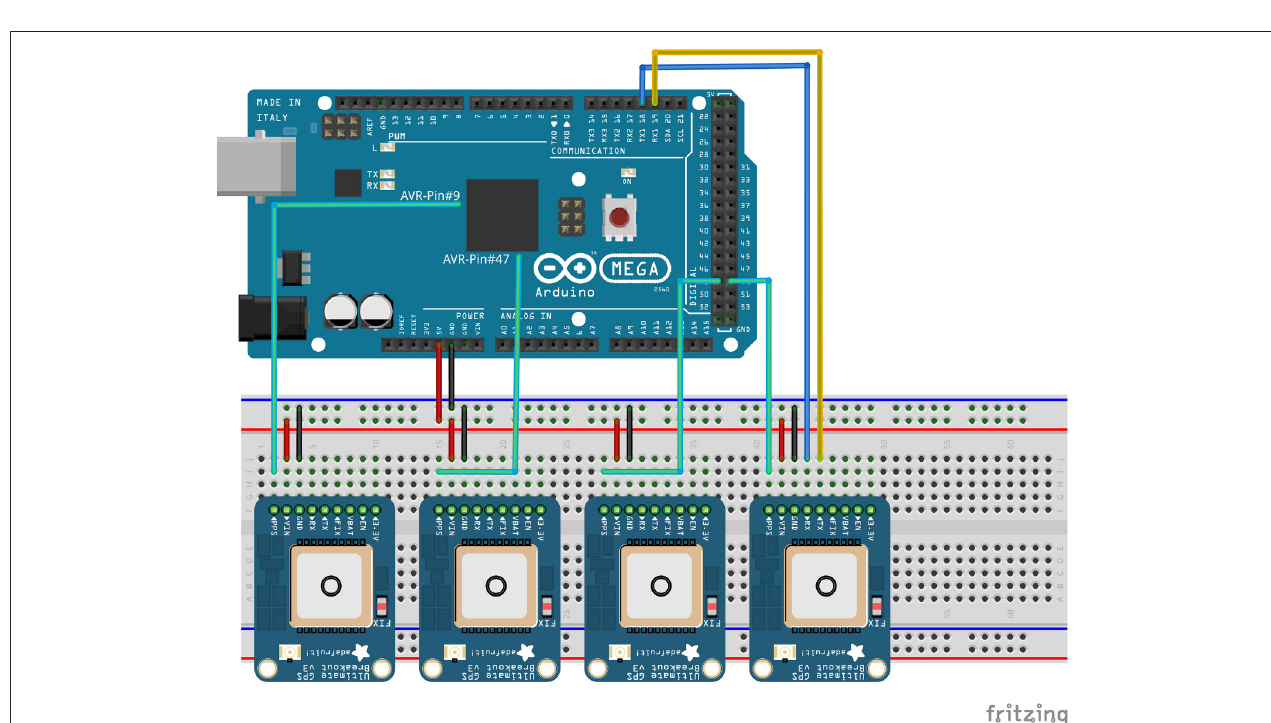
FIGURE 11 | Experimental setup for measuring accuracy of PPS signals.